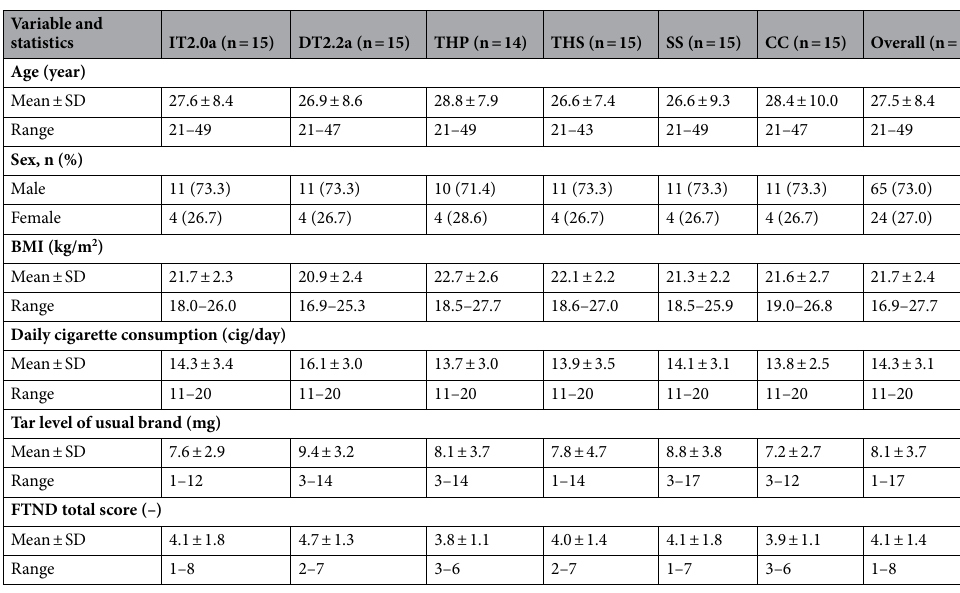
Table 3. Demographic characteristics by study group, at baseline. BMI body mass index, CC combustible cigarettes group, DT2.2a direct tobacco heating system platform 2 generation 2 version a group, FTND tobacco heating system group.